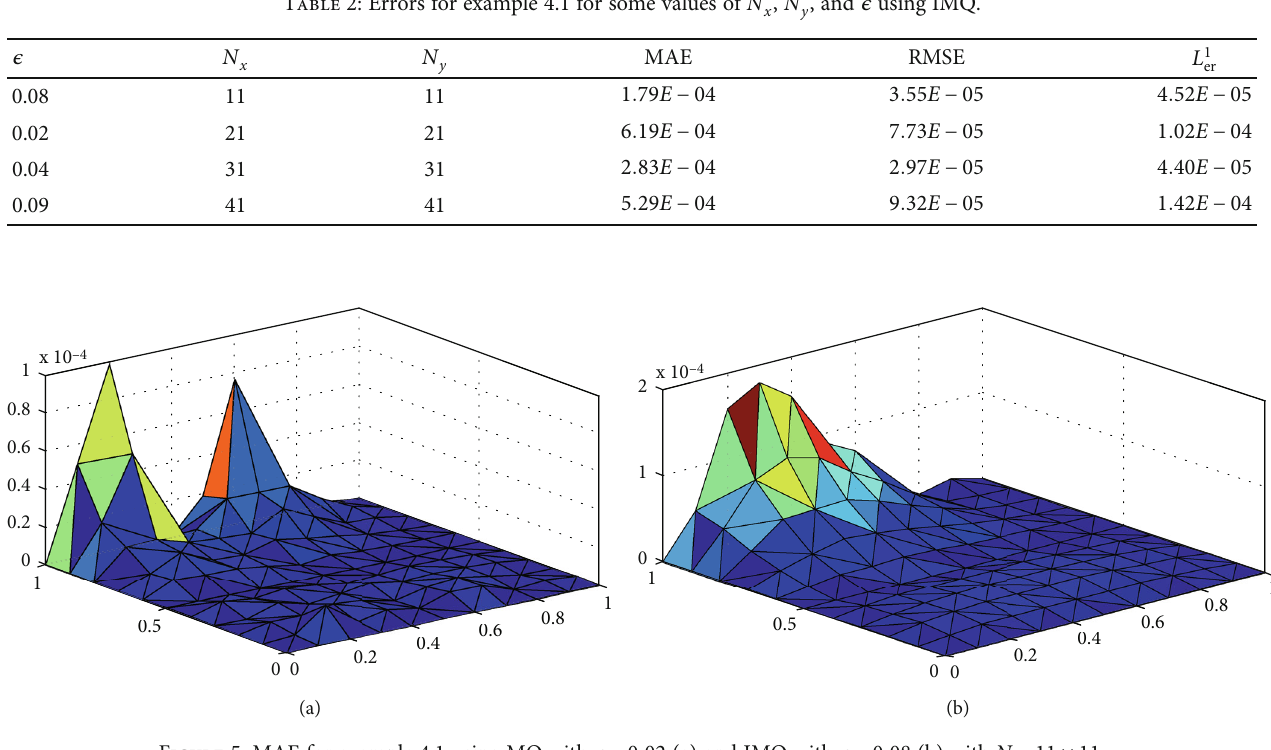
Table 1: Errors for example 4.1 for some values of N